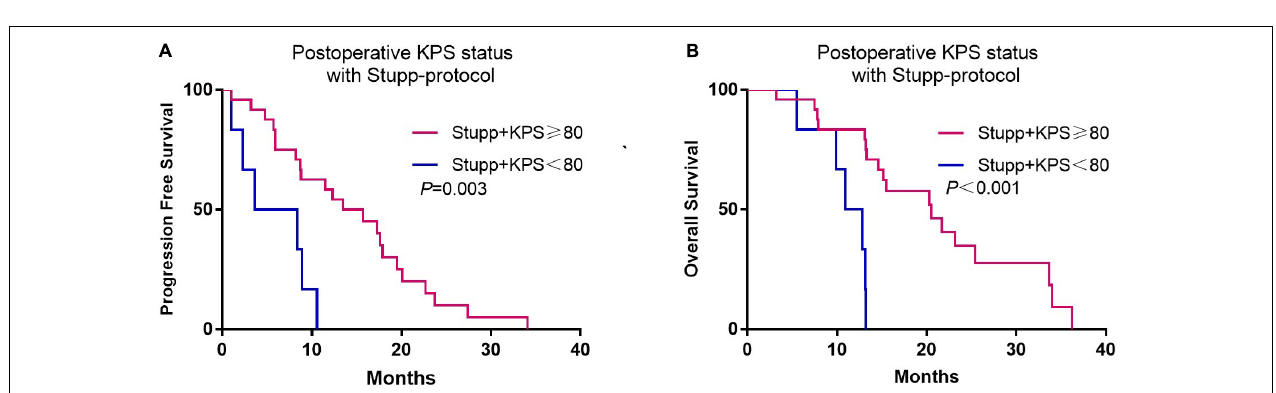
FIGURE 3 | Kaplan-Meier curves of progression-free survival (A) and overall survival (B) according to postoperative KPS status (KPS ≥ 80 and KPS < 80) for patients who received standard Stupp-protocol.